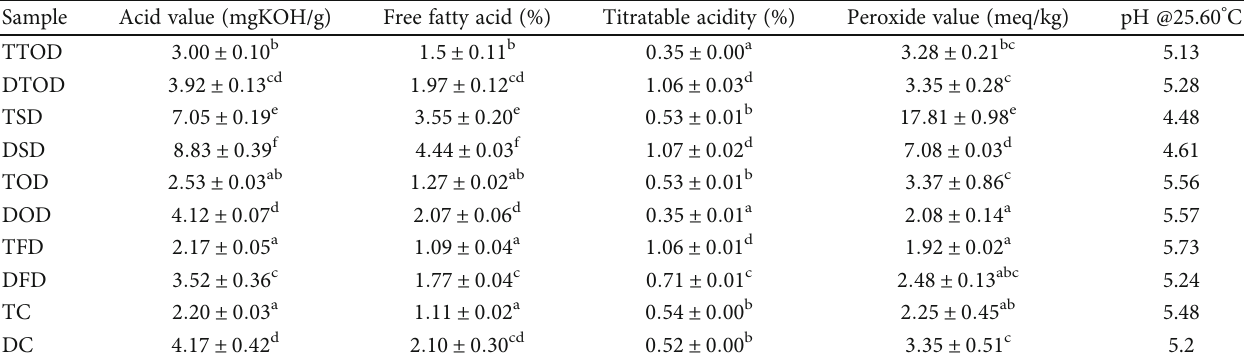
Values represent mean ± SD of at least three replicates. Means in the same column with the same superscript are not signi fi cantly di ff erent ( p > 0 : 05 ). TTOD: tenera traditional oven dried; DTOD: dura traditional oven dried; TSD: tenera solar dried; DSD: dura solar dried; TOD: tenera oven dried; DOD: dura